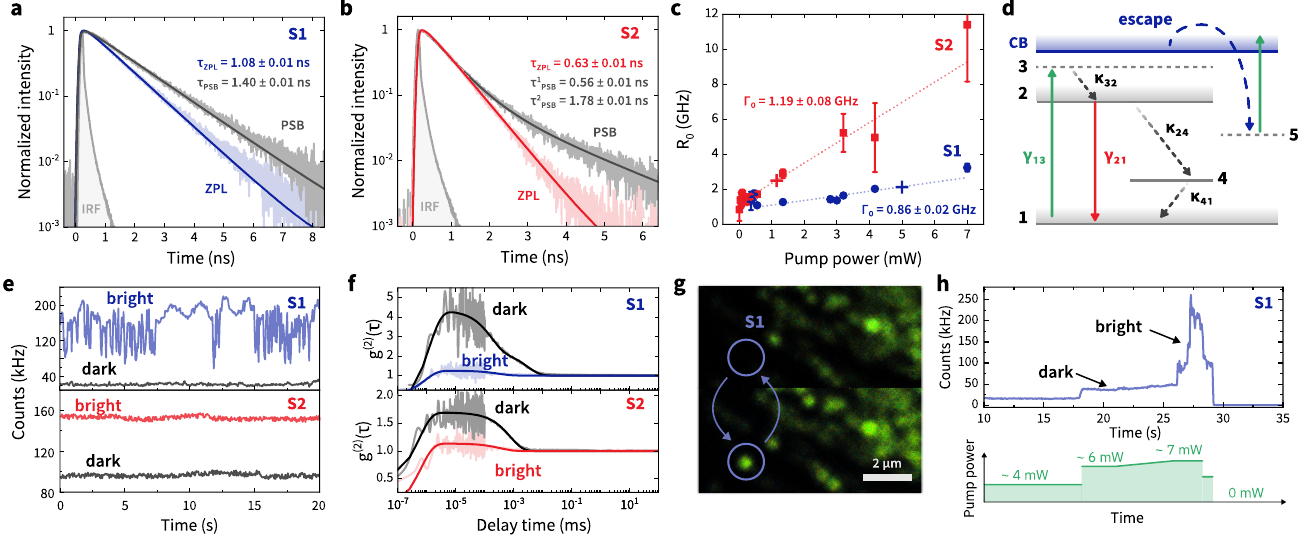
Figure 4. Spectrally filtered PL decay curves and fits to the data for S1 ( a ) and S2 ( b ) emitters at pulsed (80 MHz) 530-nm laser excitation. The light grey curve represents the IRF; ( c ) dependencies of transition rates for S1 and S2 on excitation power extracted from the g ( 2 ) ( τ ) fit. The error bars represent one standard deviation. The cross mark indicates the saturation power for each emitter; ( d ) proposed energy level structure of an hBN defect with a metastable state indicated as 4; ( e ) PL trace for the S1 (top) and S2 (bottom) emitters at 532-nm laser excitation in the dark and bright states; ( f ) full-scale g ( 2 ) ( τ ) functions for S1 (top) and S2 (bottom) in the dark and bright states. Solid curves are the g ( 2 ) ( τ ) functions simulated to fit the experimental data; the procedure is described in Appendix B; ( g ) photoluminescence intensity map with deactivated (top) and activated (bottom) S1 emitter; ( h ) switching from the dark to the bright state for S1 emitter (top) via experimental protocol with 532-nm excitation